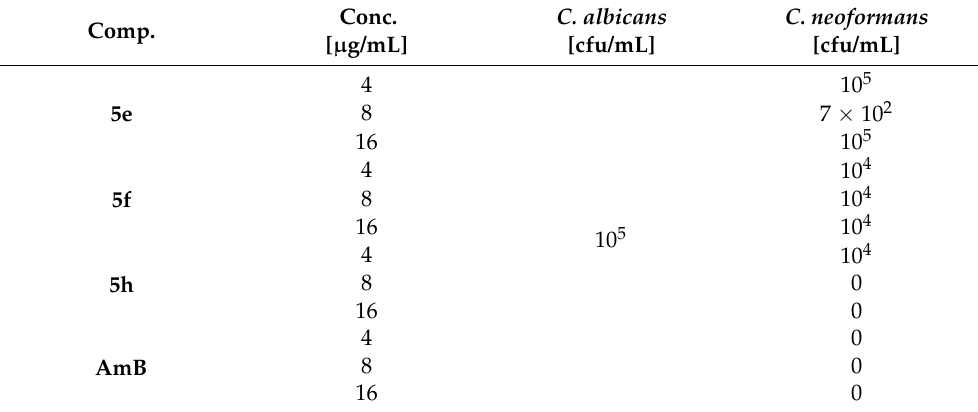
Table 4. Recovery of the colony forming units of the fungal isolates after 48 h-treatment with N -phenacyldibromobenzimidazole. Comp.